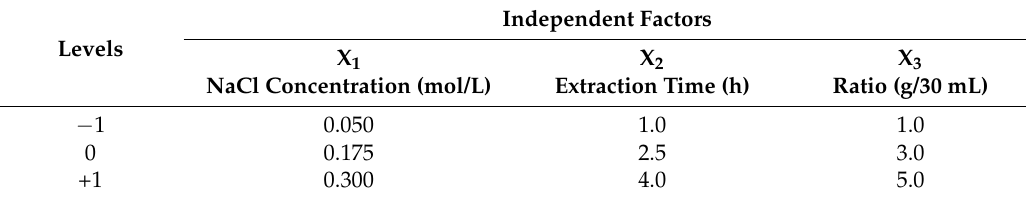
Table 1. Independent factors and their levels for the RSM Box–Behnken design. Levels